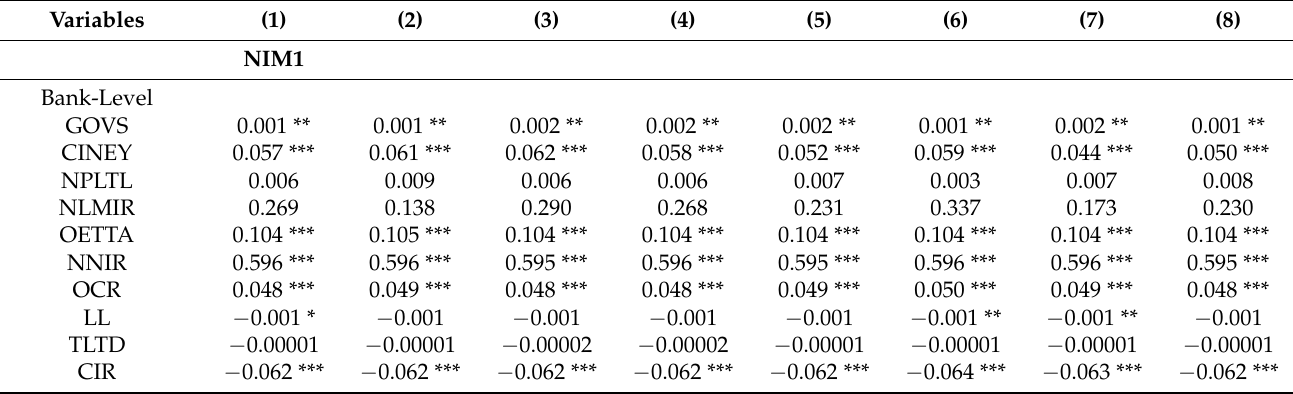
Table 8. Regression for BRICS